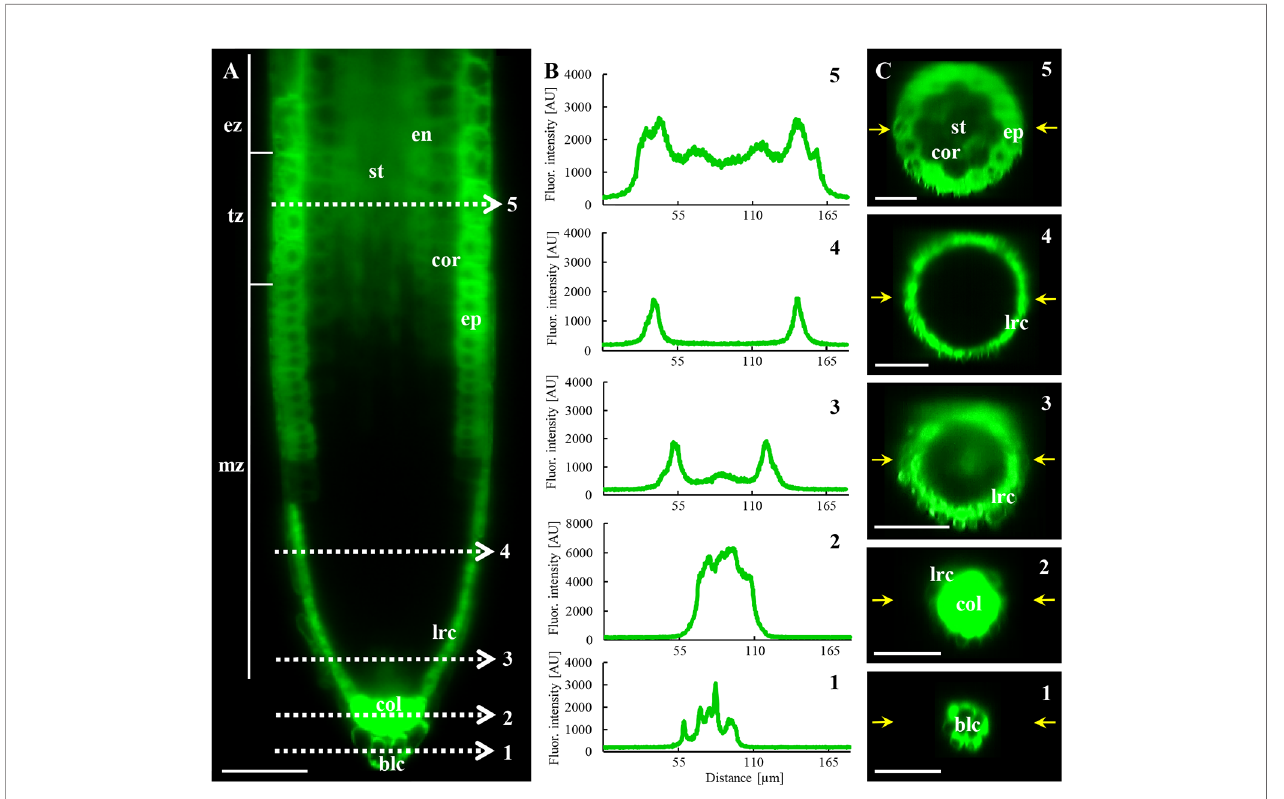
FIGURE 3 | In vivo localization of ANN1-GFP in meristematic and transition zone of primary root in A. thaliana expressing proANN1::ANN1:GFP construct using LSFM. (A) Medial optical section of the primary root showing the distribution pattern of ANN1-GFP expression. Strong level of ANN1-GFP production is visible in the columella cells (col) and in lateral root cap cells (lrc). Cells of the root meristematic zone (mz) are devoited of ANN1-GFP. The signal of ANN1-GFP is enhanced in epidermal cells (ep) within the meristematic zone and stays strong through the transition (tz) to elongation zone (ez). Starting in the transition zone (tz) ANN1-GFP is produced also in inner root tissues: cortex (cor), endodermis (en), and stele (st). White dashed lines (1 – 5) indicate the position of the pro fi les along which the fl uorescence intensities, showed in (B) , were measured for quantitative evaluation of ANN1-GFP distribution. (C) Distribution of ANN1-GFP visualized in radial root sections prepared from orthogonal projections of the root apex at the position of respective fl uorescence intensity pro fi les in (A) , indicated by yellow arrows. Scale bars = 50